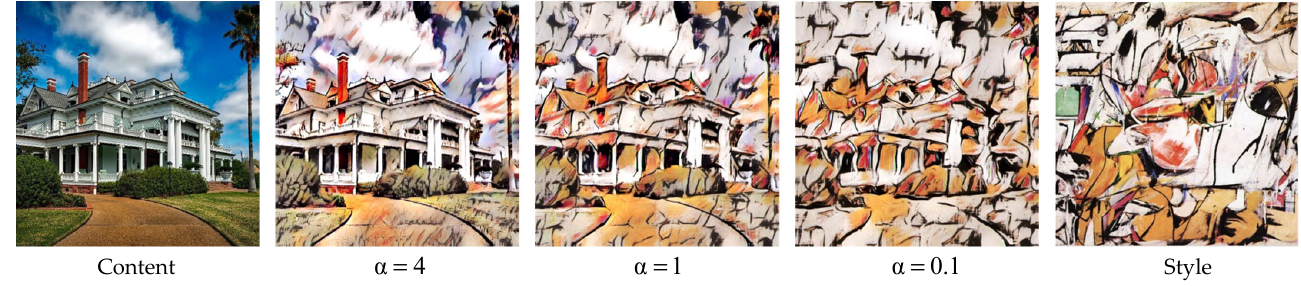
Figure 15. Trade-off of content-style losses.